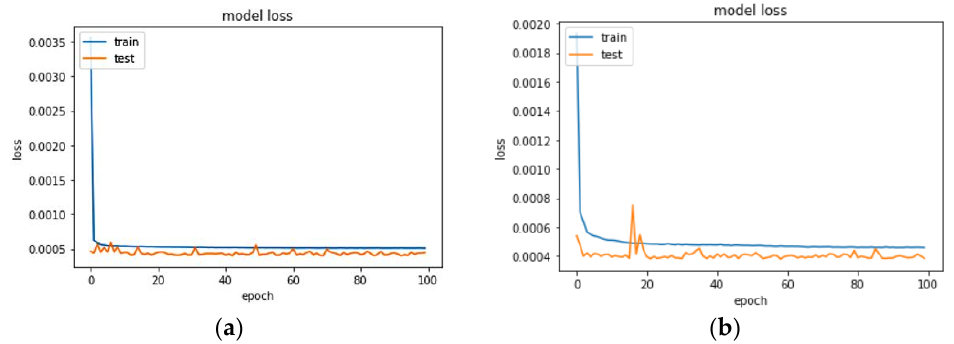
Figure 6. Model fitting test and train loss minimization for ( a ) Multi-headed CNN ( b ) and Simple CNN structure.